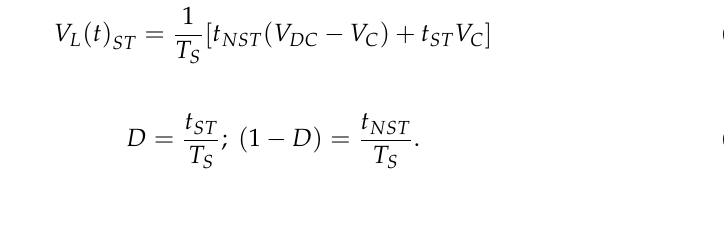
Figure 7. Electrical diagram of Z-source converter in the Shoot-Through (ST) state.